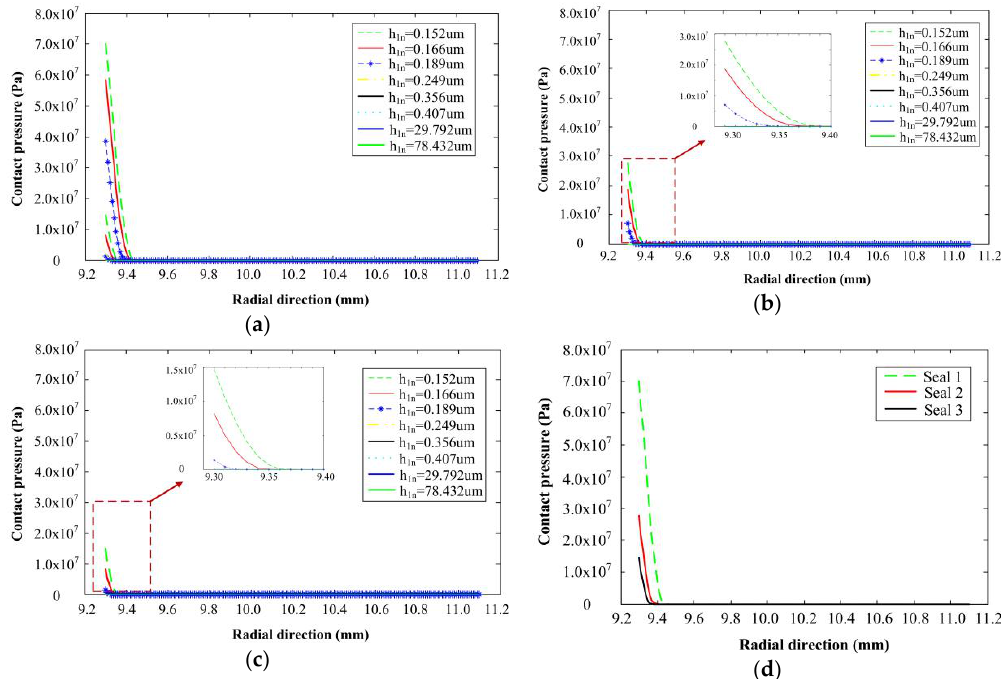
Figure 10. ( a ) Contact pressure p c of the non-Gaussian surfaces of seal 1 for different values of h 1n ; ( b ) contact pressure p c of the non-Gaussian surfaces of seal 2 for different values of h 1n ; ( c ) contact pressure p c of the non-Gaussian surfaces of seal 3 for different values of h 1n ; ( d ) contact pressure p c of the non-Gaussian surfaces for seal 1, seal 2, and seal 3 with h 1n = 0.152 µm .